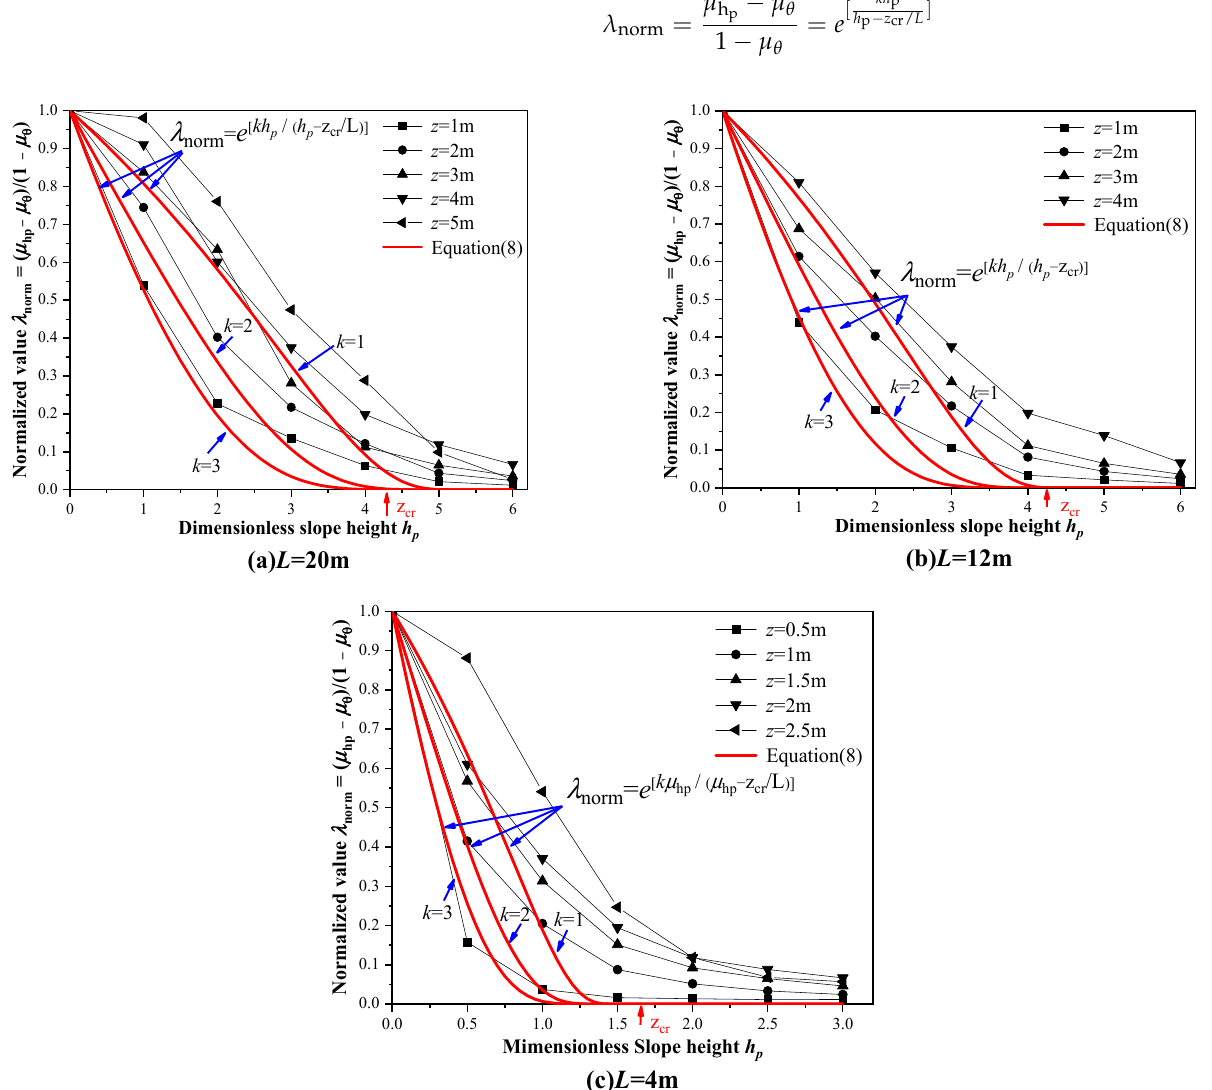
Figure 16. The variation of λ norm with h p for ( a ) L = 20 m, ( b ) L = 12 m, and ( c ) L = 4 m. Rearranging Equation (15), µ h can be calculated as the following when h p < z cr / L : p (cid:3174) (cid:3436) )𝑒 𝜇 = 𝑓(cid:3435)ℎ , 𝜇 (cid:3439) = 𝜇 + (1 − 𝜇 (cid:2918) (cid:3174) (cid:2926) (cid:2968) (cid:2968) (cid:2968) where 𝑧 (cid:2913)(cid:2928) is calculated to be 1.6 m, 4.2 m, and 4.26 m with Equations (11) and (13), for pile lengths of 4 m, 12 m, and 20 m, respectively; 𝑘 is a parameter that controls the shape depths with the increase of 𝑘 . To fit more cases of depths, 𝑘 = 2 is considered to be suit-